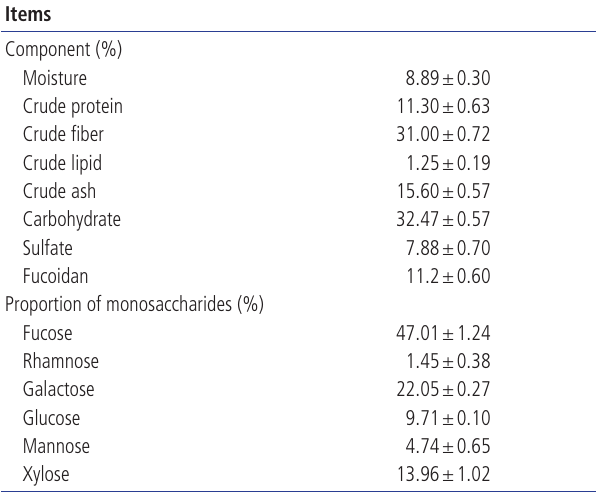
Table 2. Chemical composition of Ecklonia cava